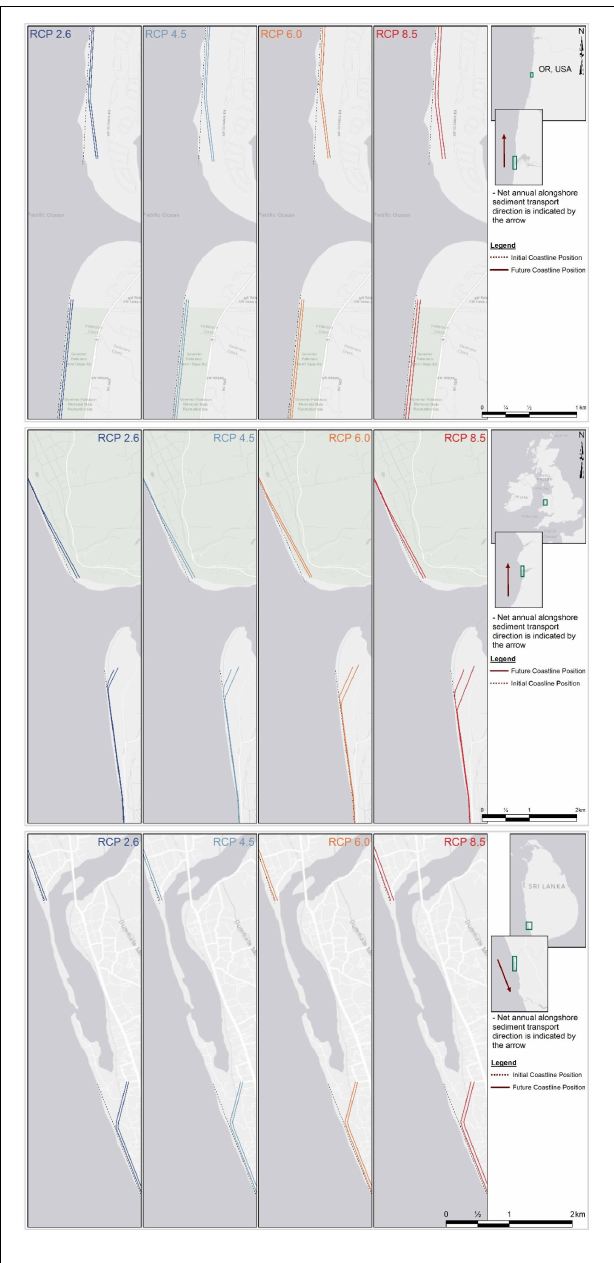
FIGURE 10 | Projected changes of the coastline adjacent to Alsea estuary (top) , Dyfi estuary (middle) , and Kalutara estuary (bottom) (excluding ambient coastline change). The two solid lines in each subplot represent the coastline position by 2060 and 2100 (in the same order, moving landward from the most seaward line). The dotted line in each subplot represents the initial (reference) coastline position considered.